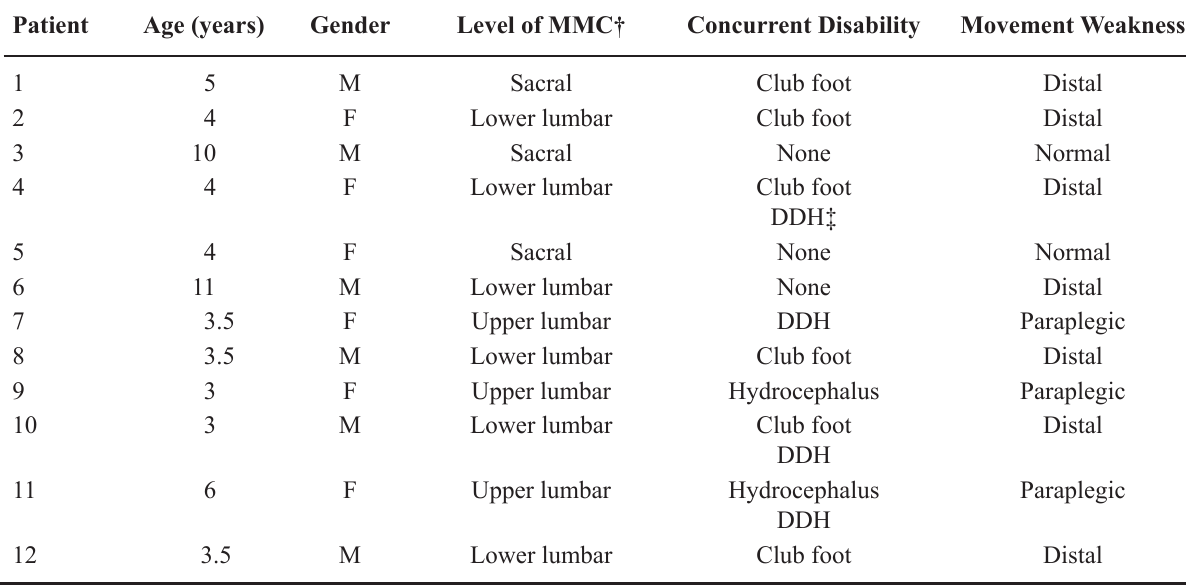
Table 1 – Clinical features and underlying pathology of children with